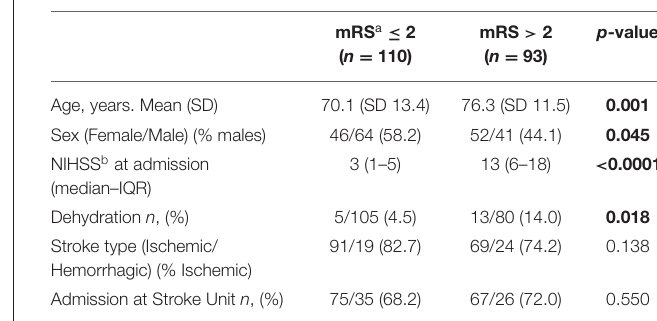
TABLE 3 | Comparison of clinical features in patients with good prognosis (mRS ≤ 2) and poor prognosis (mRS > 2) 3 months after the stroke and p -values from statistical